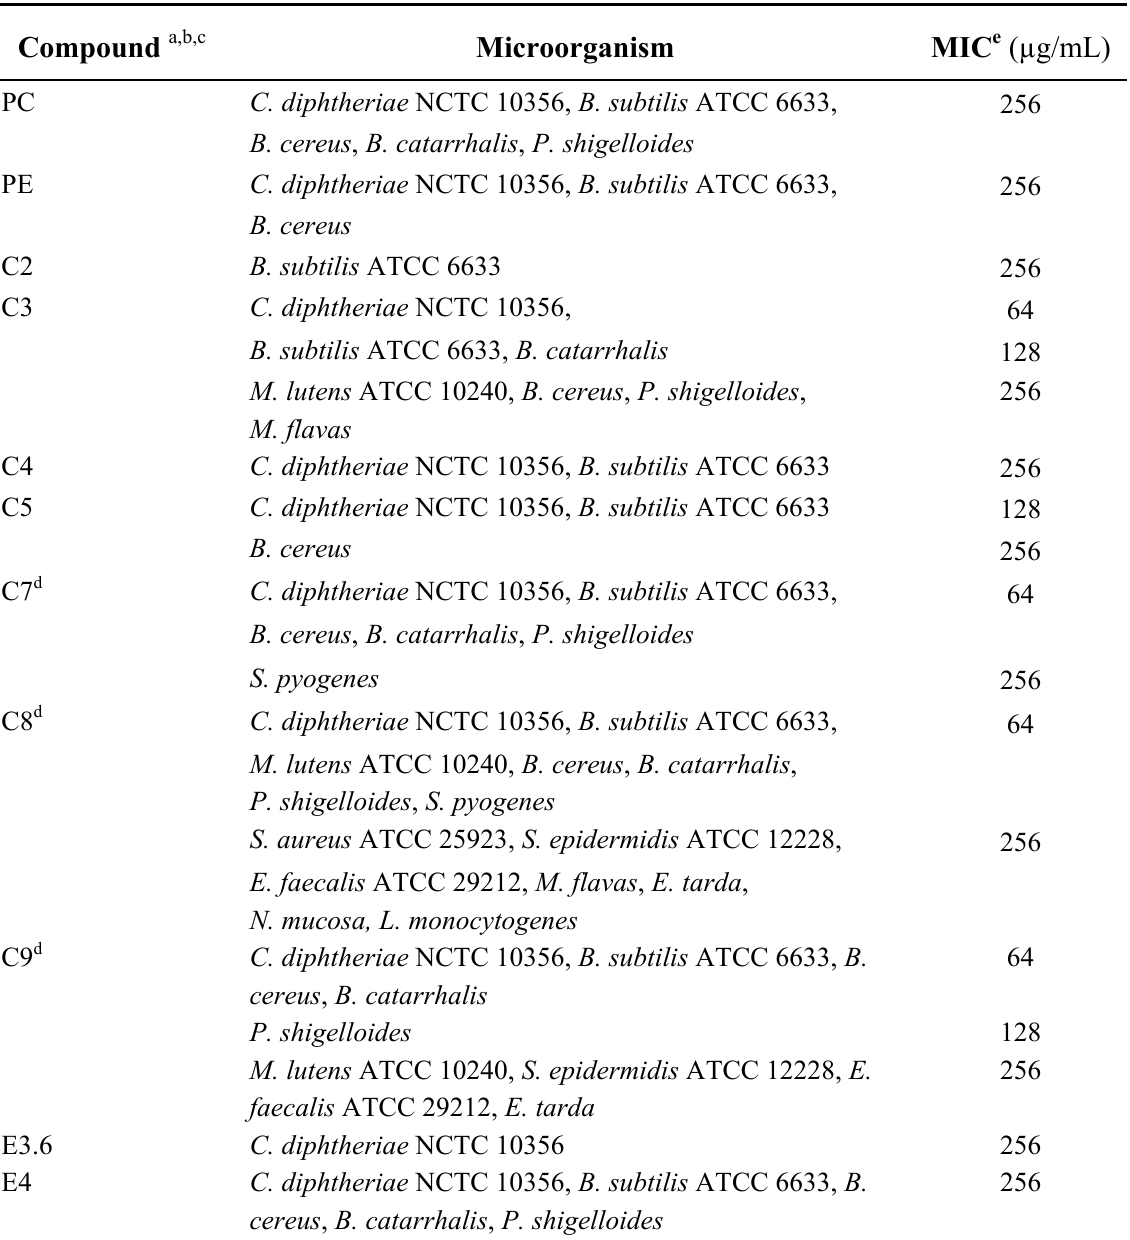
Table 1. Antimicrobial activity* of P. debilis